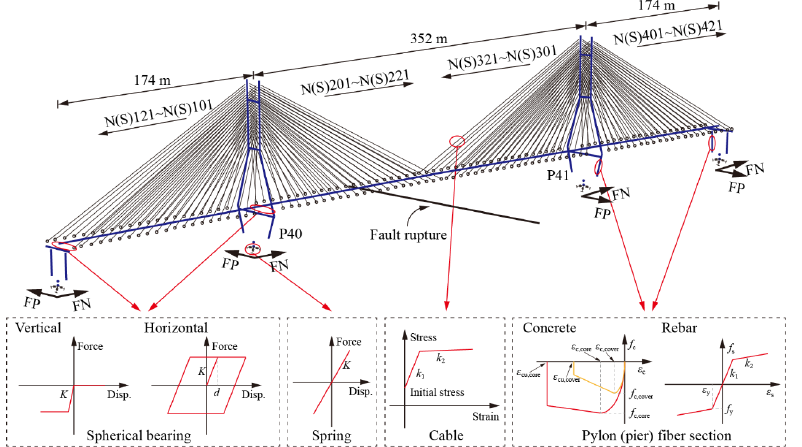
Buildings 2022 , 12 , x FOR PEER REVIEW Figure 2. Configuration of the case study bridge. Figure 2. Configuration of the case study bridge.